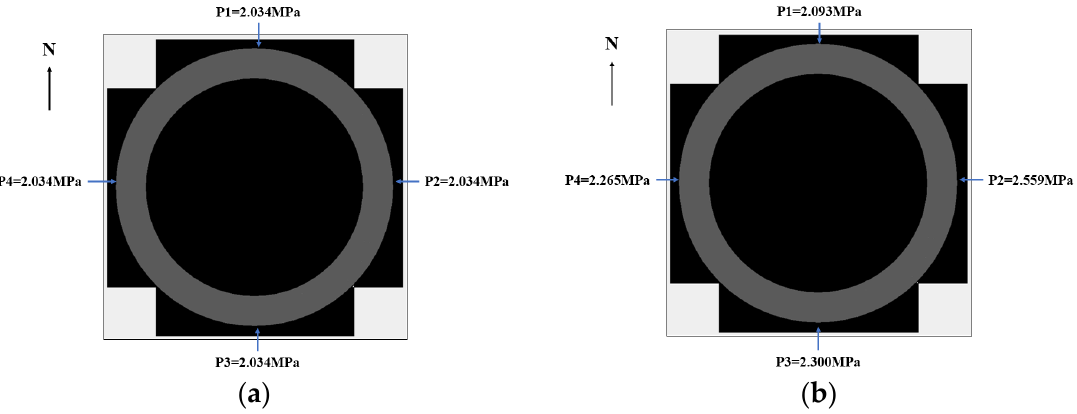
Figure 20. S1ZK0 + 660 m section RFPA load loading plan. ( a ) Uniform pressure; ( b ) Non ‐ uniform pressure.